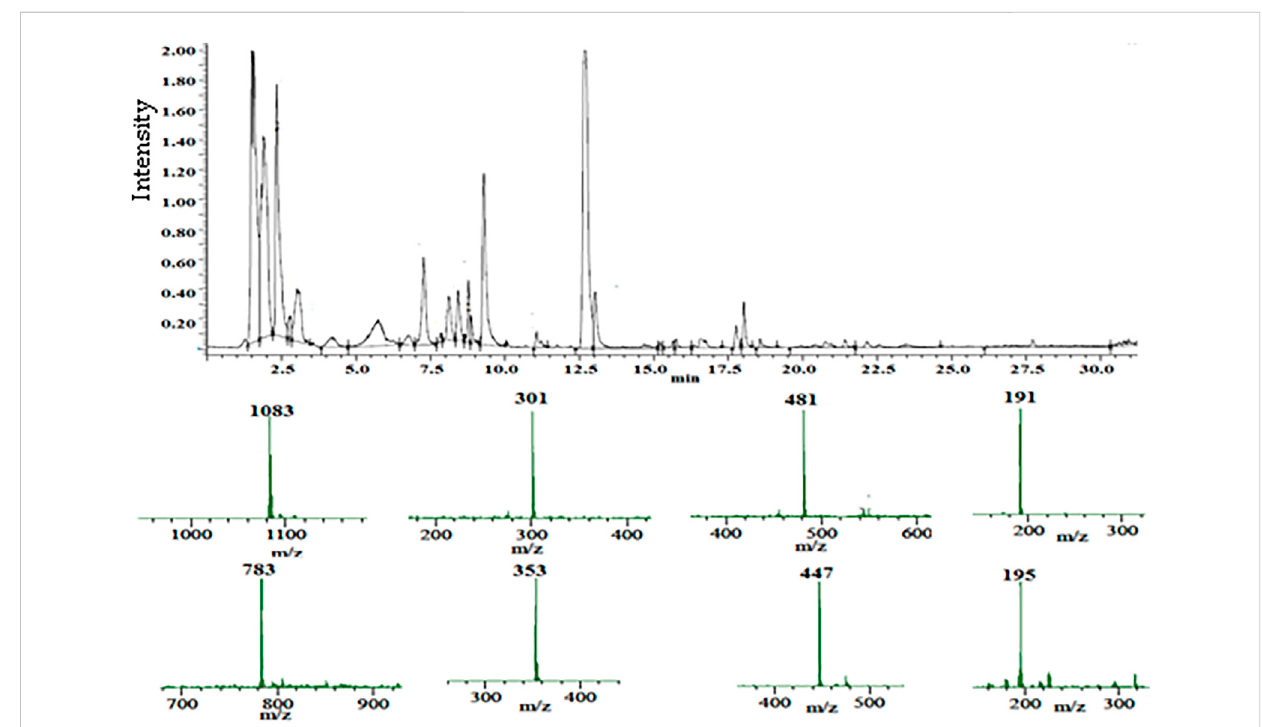
FIGURE 1 Total ion chromatogram of the UPLC-PDA-MS/MS analysis of the pomegranate peel extract PPE (top), and the mass spectra of the major constituents